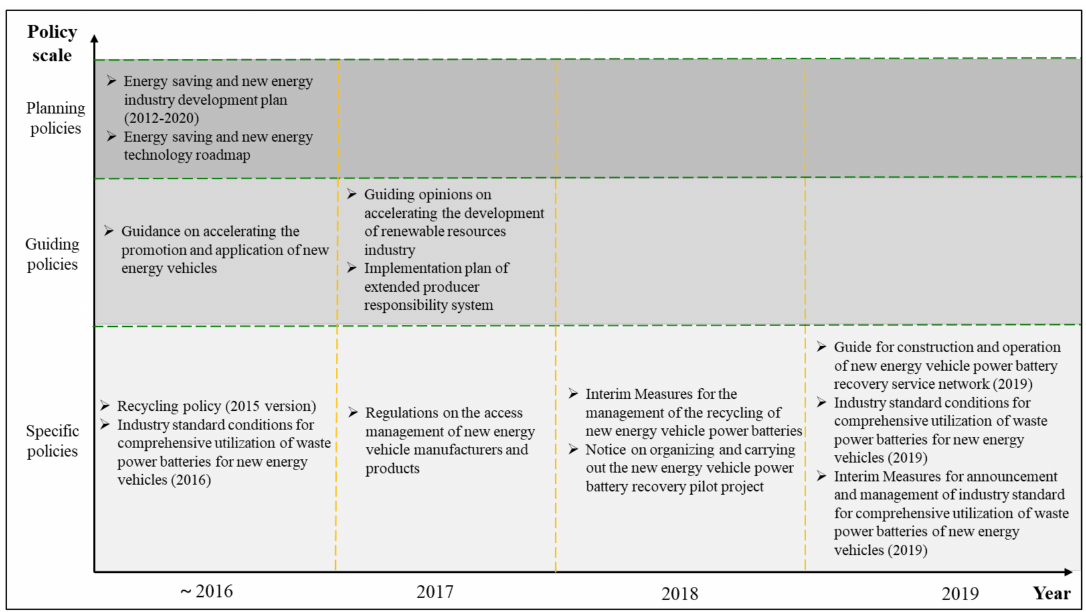
Figure 2. List of relevant policies for power battery reusing in